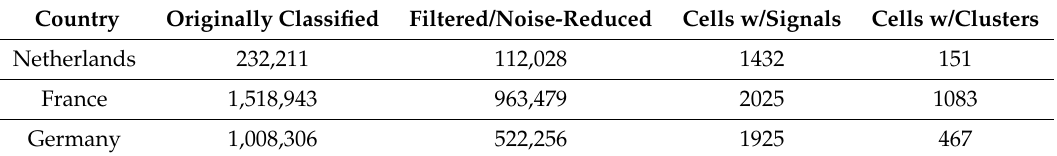
Figure 11. Heatmap of Europe showing the density of streets mapped to German street specifics. Colors indicate the density of streets in this area, thus the logarithmic value of the number of streets normalized by all streets in the cell of the grid. Table 3. Number of streets in Europe that have been mapped to Dutch, French and German streets. After a first classification, the resulting set is filtered again in order to reduce noise and remove streets that are classified by many different countries. In this way, street specifics that are used in many countries and languages are removed (i.e., popular first